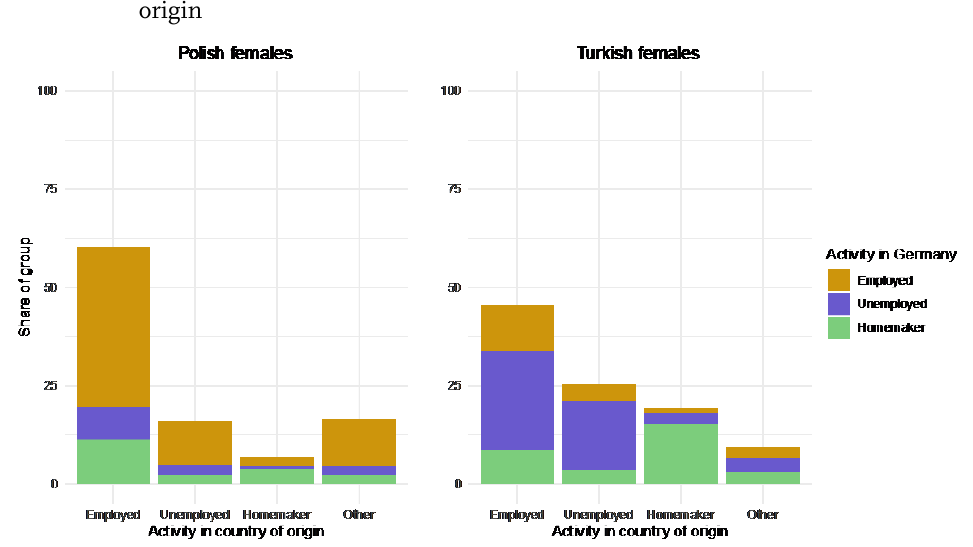
Figure 1 : Activity status at the time of the interview by activity status in the country of